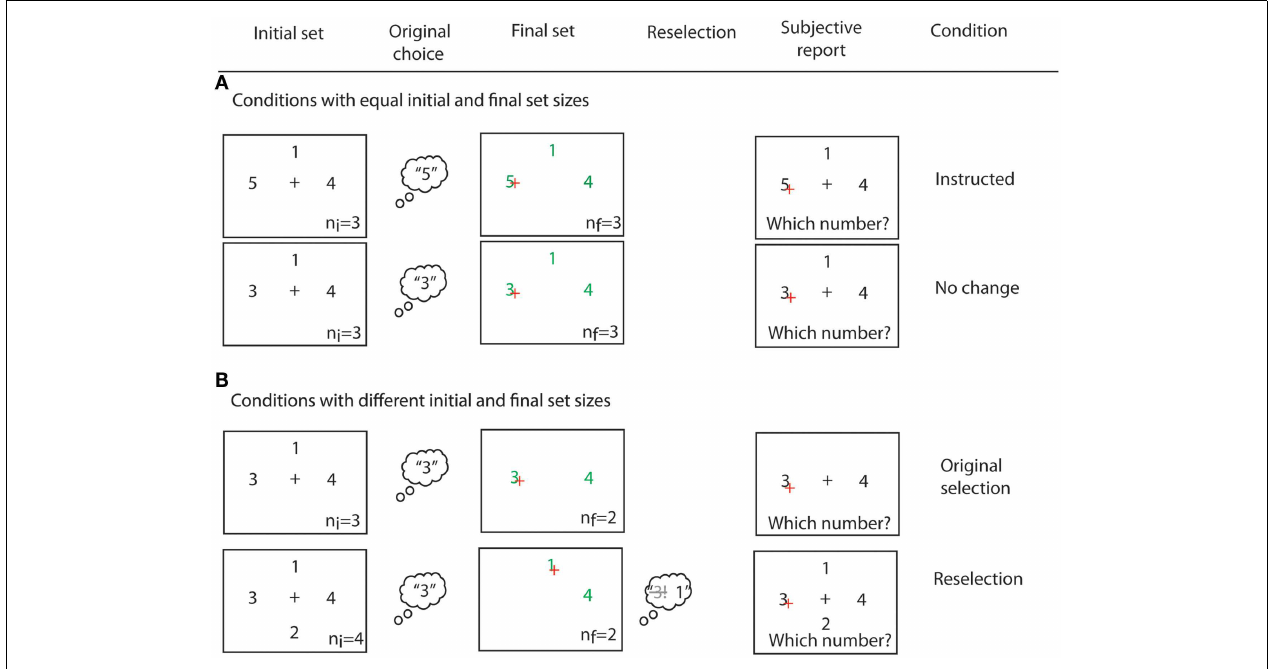
disappeared from the initial response set. A trial was sorted as original selection if participants reported that their original choice matched their final choice. Instead, a trial was sorted as reselection if participants reported having chosen a number that had become unavailable. n i and n f indicate the initial and final response set sizes, respectively.They were not displayed in the